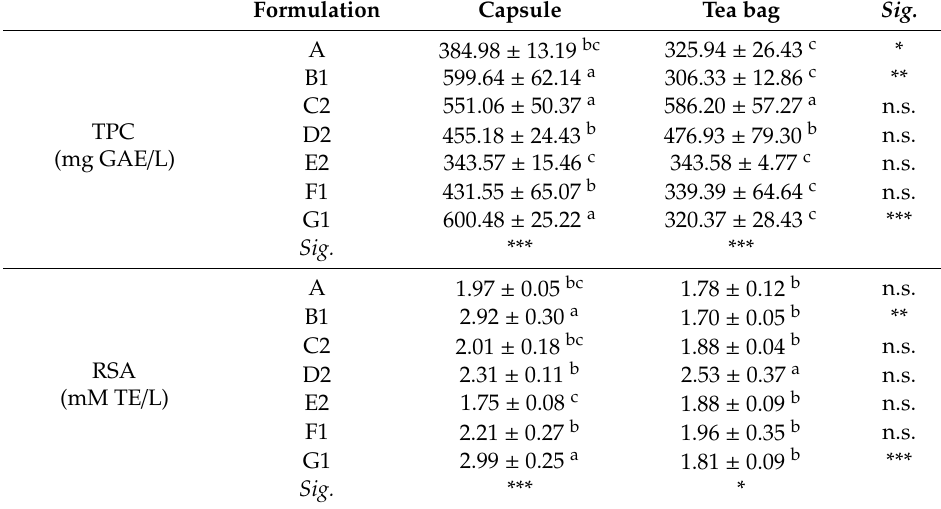
Table 3. Values (mean ± standard deviation) of total phenolic content (TPC) and radical scavenging activity (RSA) for beverages obtained with capsule and tea bag extraction techniques and results of analysis of variance (ANOVA) with Duncan’s test performed between formulations for each extraction method (columns) and between extraction methods for each formulation